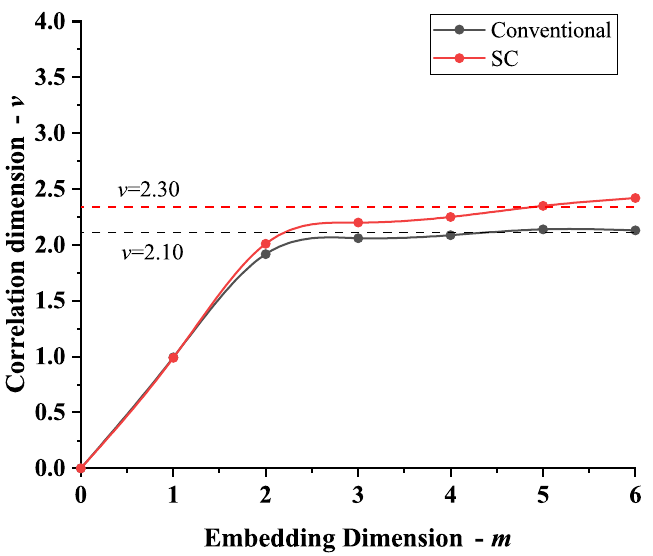
Figure 12. Correlation Dimension for the conventionally calculated Z ( t ) time series (black line) and the one calculated in the SC environment (red